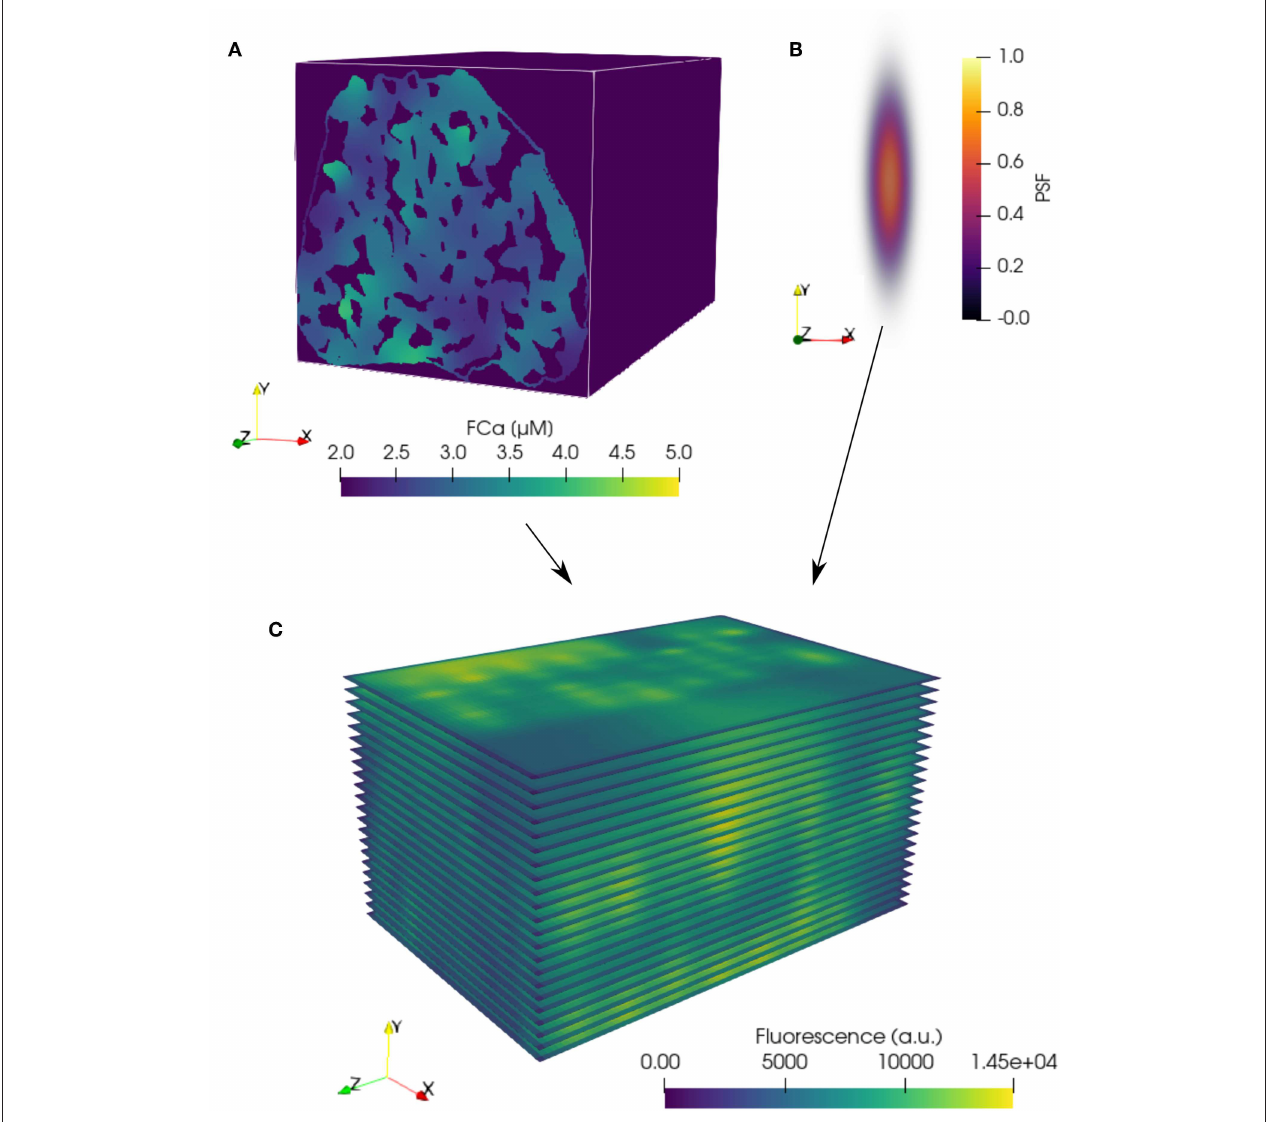
FIGURE 2 | Simulation of confocal fluorescence microscopy images from FE model results. (A) FE FCa field data (see Figure 1E ) interpolated onto a regular grid with 53.75 nm resolution in each coordinate direction. Three-dimensional convolution of the interpolated FCa data with a (B) point spread function (PSF) produces blurring typical of confocal fluorescence microscopy data. (C) Blurred data resampled at a pixel resolution of 215 nm within the 22 simulated two-dimensional imaging planes in the volume. (A,C) are shown at a single time point, t = 15